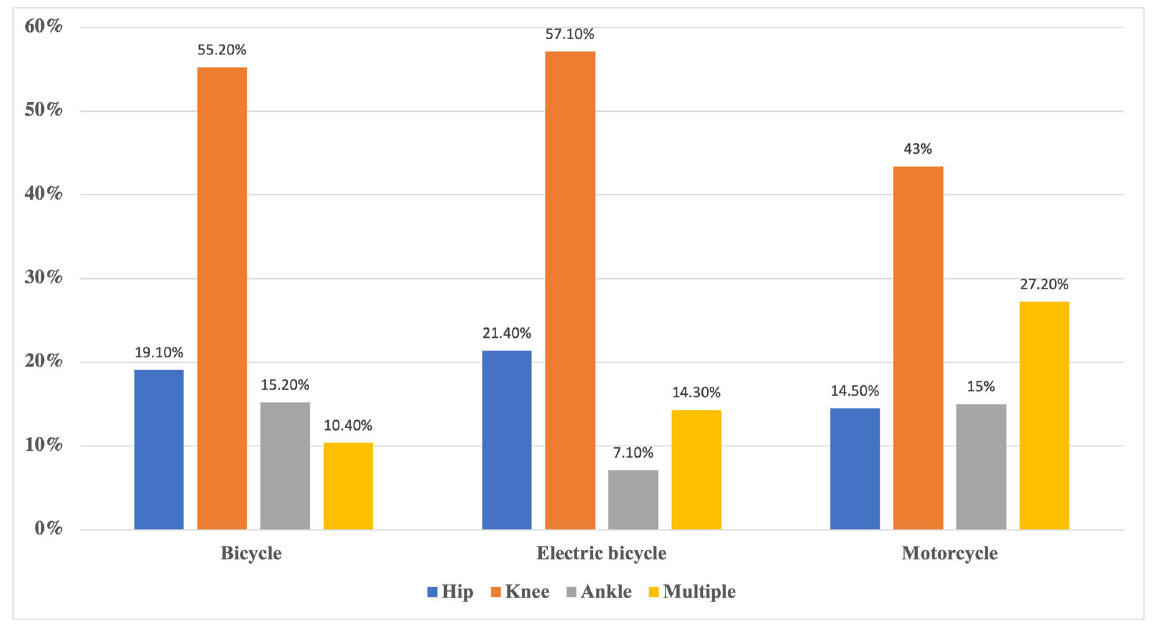
Figure 4. Distribution of soft tissue injuries/contusions stratified by vehicle. Bars show percentages of contusions to the hip, knee, ankle, or multiple locations amongst the total number of contusions stratified by the used vehicle.